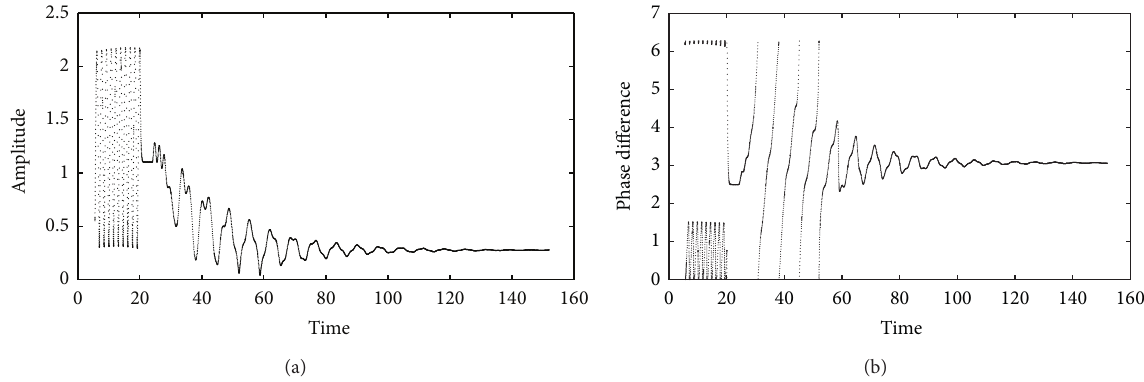
Figure 5: Control result at 𝜔 = 1.9 . Time history of (a) the radial displacement amplitude and (b) phase difference.